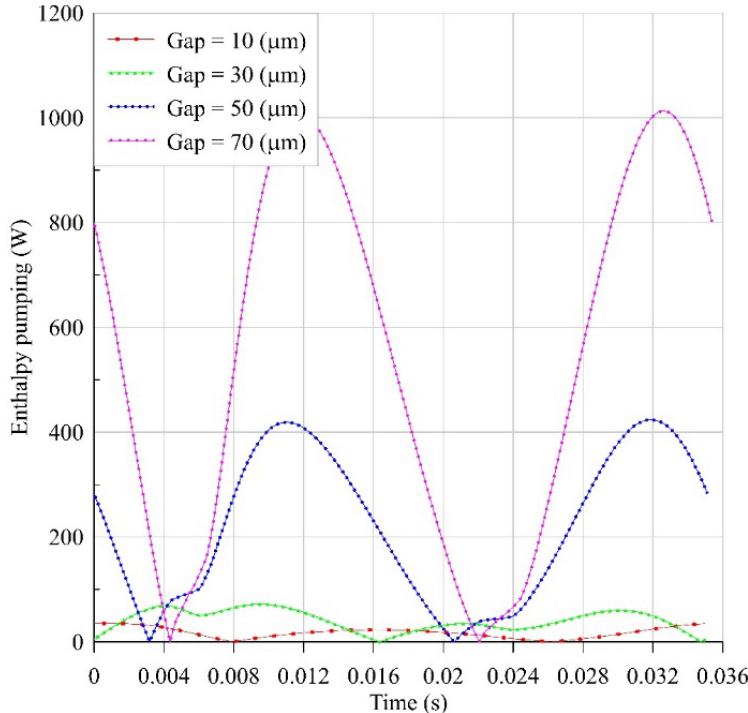
Figure 15. Coupled enthalpy pumping at different gap sizes.